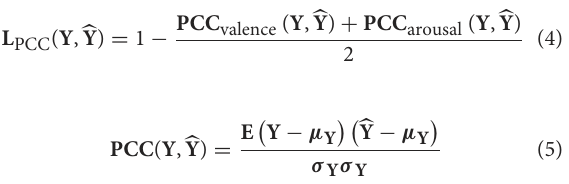
Residual connections were used between layers, and the feature size was 128 × 128 ×